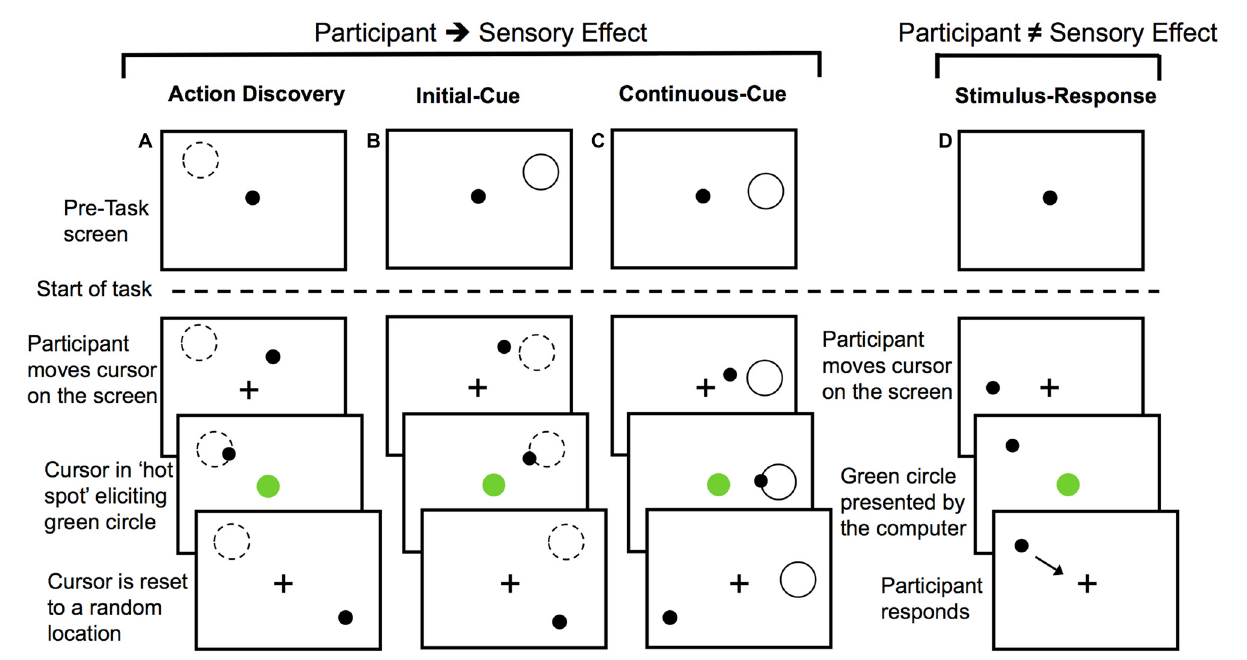
FIGURE 1 | Diagram of the experimental tasks. For action discovery (AD) task (A) , the initial-cue (IC) task (B) , and the continuous-cue (cc) task (C) the sensory effect (green circle) was presented when participants moved the cursor into the “hot spot”. In the action control tasks (B,C) , the pre-task screen provided information about the location of the “hot spot”. After each presentation of the sensory effect the cursor was reset to a new location. Participants attempted to elicit the sensory effect after each cursor reset. Dashed-line circle indicates the location of the “hot spot” when it was not visible to the participant and the green circle represents the sensory effect. In the stimulus-response (SR) task (D) participants made voluntary movements, however, the presentation of the sensory effect was unrelated to their movements. Presentation of the sensory effect was computer-controlled. Participants responded to the green circle by moving the cursor to the fixation cross and then continued to make voluntary movements around the